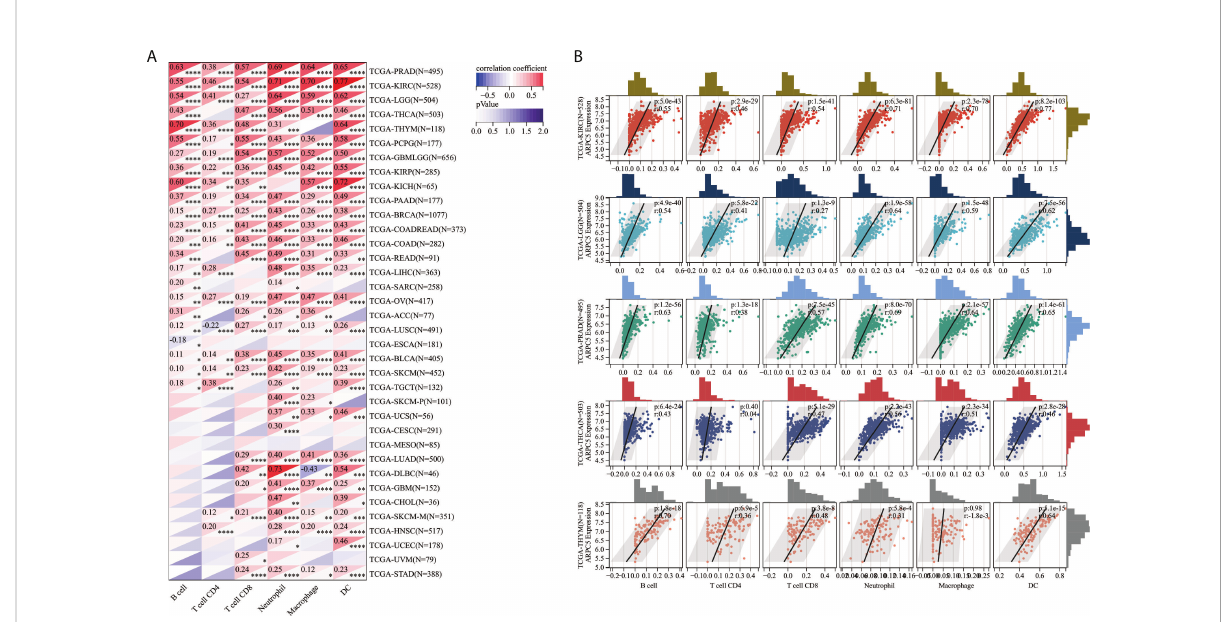
FIGURE 6 The correlation between ARPC5 and immune in fi ltration cells in pan-cancer based on TIMER algorithm. (A) Heatmap displayed the correlation between ARPC5 expression and the proportions of B cell, CD4 + T cell, CD8 + T cell, neutrophil, macrophage, and DC cell. (B) The top fi ve cancer types (including KIRC, LGG, PRAD, THCA, and THYM) with most signi fi cant correlation between ARPC5 and immune in fi ltration cells were displayed with scatterplots. * p < 0.05; ** p < 0.01; *** p < 0.001; **** p <